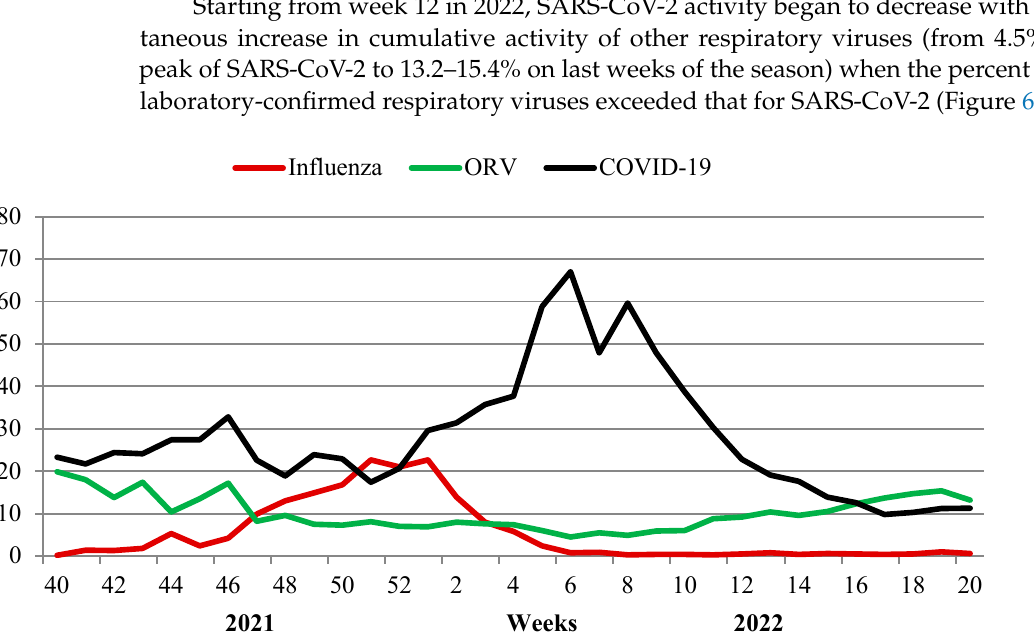
Table 1. Age ‐ specific peculiarities of the etiology of respiratory viral infections according to PCR data under non ‐ sentinel surveillance, season 2021–2022.